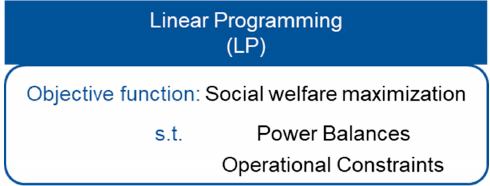
Figure 1. Market clearing